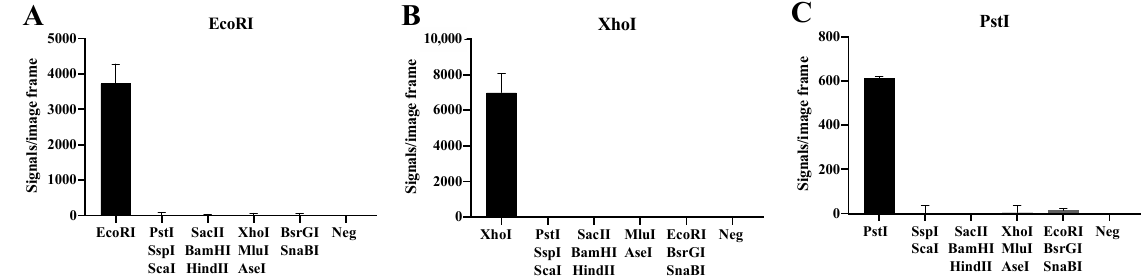
Figure 2. Specific detection of purified REs. The DNA substrate systems for EcoRI ( A ), XhoI ( B ) and PstI ( C ) were incubated with their target RE and a mixture of two to three non-target REs (SacII, SspI, BamHI, HindIII, MluI, AseI, SnaBI and BsrGI. A negative control (Neg) with buffer alone was included. The data are plotted as the mean of signals/image frame with standard deviation, n = 3.